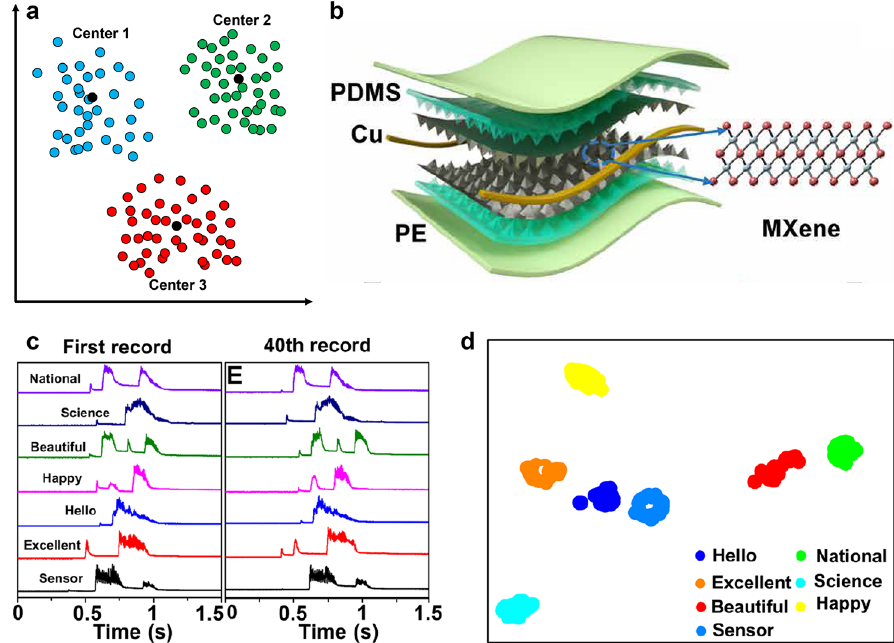
Fig. 22 Signals detected by the soft system and processed by K-means. a Schematic diagram of K-means. b Schematic diagram of the MXene eardrum. The device consists of two layers of MXene-PDMS-PE film. c Normalized response waveform of seven kinds of words recorded for the 1st and 40th times by the MXene eardrum. d Visualizing the pronunciation information of seven kinds of words within 280 voices after dimen- sionality reduction. Reproduced with permission [26]. Copyright (2022), American Association for the Advancement of